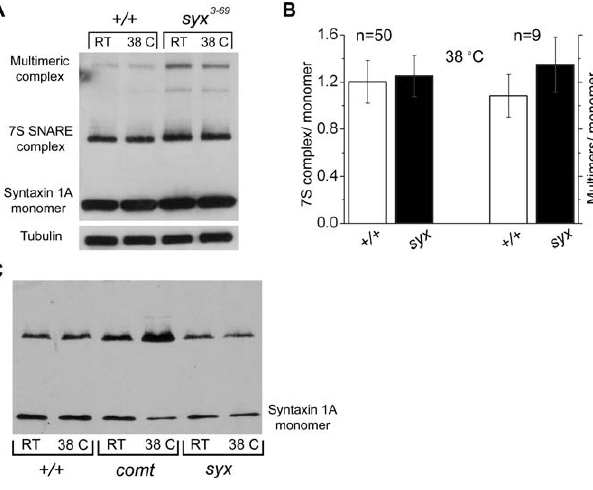
Figure 4. The SNARE Complexes Remain in syx 3–69 Mutant Flies at the Restrictive Temperature (A and B) The SDS-resistant complex is not obviously affected in homozygous syx 3–69 mutant flies at restrictive temperatures. A repre- sentative Western blot shows the syntaxin 1A monomer, the 7S SNARE complex, and the multimeric complex obtained from heads of the wild type ( þ / þ ) and the syx 3–69 mutant (A). A control for total protein loaded is illustrated by the intensity of tubulin (bottom). Histograms of ratios of the 7S and multimeric complexes to monomer in wild-type ( þ / þ ) and syx 3–69 mutant flies are shown in (B). Unless specifically noted, the complex-to-monomer ratio is normalized to that of the wild type at room temperature in this and other SNARE complex histograms. The SNARE complex was extracted from flies either at room temperature ( ; 22 8 C) or after exposure to 38 8 C for 20 min, as described above [21]. (C) An example of Western blots showing the SNARE complex in the wild-type ( þ / þ ), comatose (comt tp7 ), and syx 3–69 mutant flies. The SNARE complex accumulates in the comt tp7 mutant, likely as a result of a block of the NSF ATPase activity at the restrictive temperature. Note that even though relatively less protein was loaded in the syx 3–69 lanes (as judged by the intensity of the syntaxin band), the 7S complex remains in paralyzed syx 3–69 flies. mutant fly we studied indeed carried the T254I mutation as shown in the syx 3–69 mutant. Sequencing confirmed that there frame of syntaxin 1A (see Figure S3). Furthermore, we were